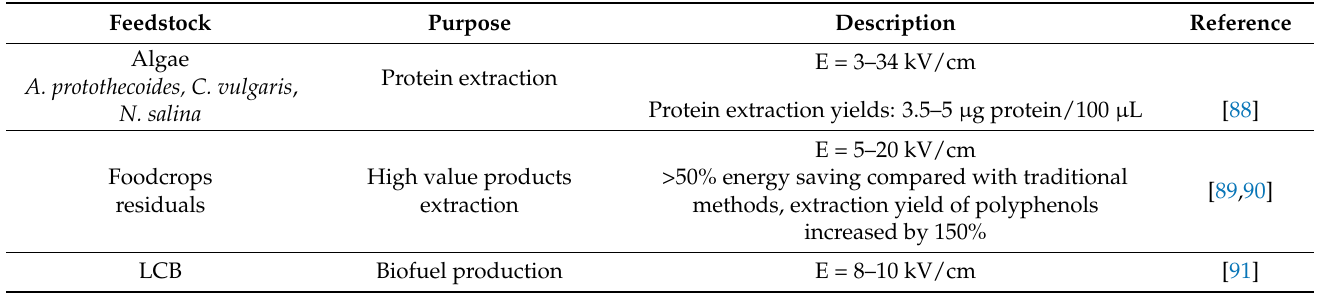
Table 3. Reported PEF applications in biomasses